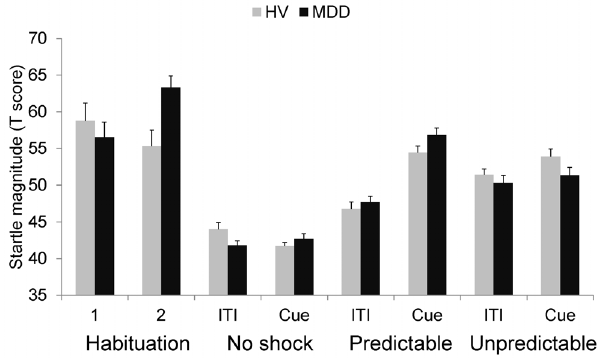
Figure 2. Startle response during NPU (raw scores). Startle magnitudes (raw scores) in the controls and patients with major depressive disorder (MDD) during the habituation procedures and during the no shock (N), predictable shock (P), and unpredictable shock (U) condition in the threat procedures. Error bars are SEM.